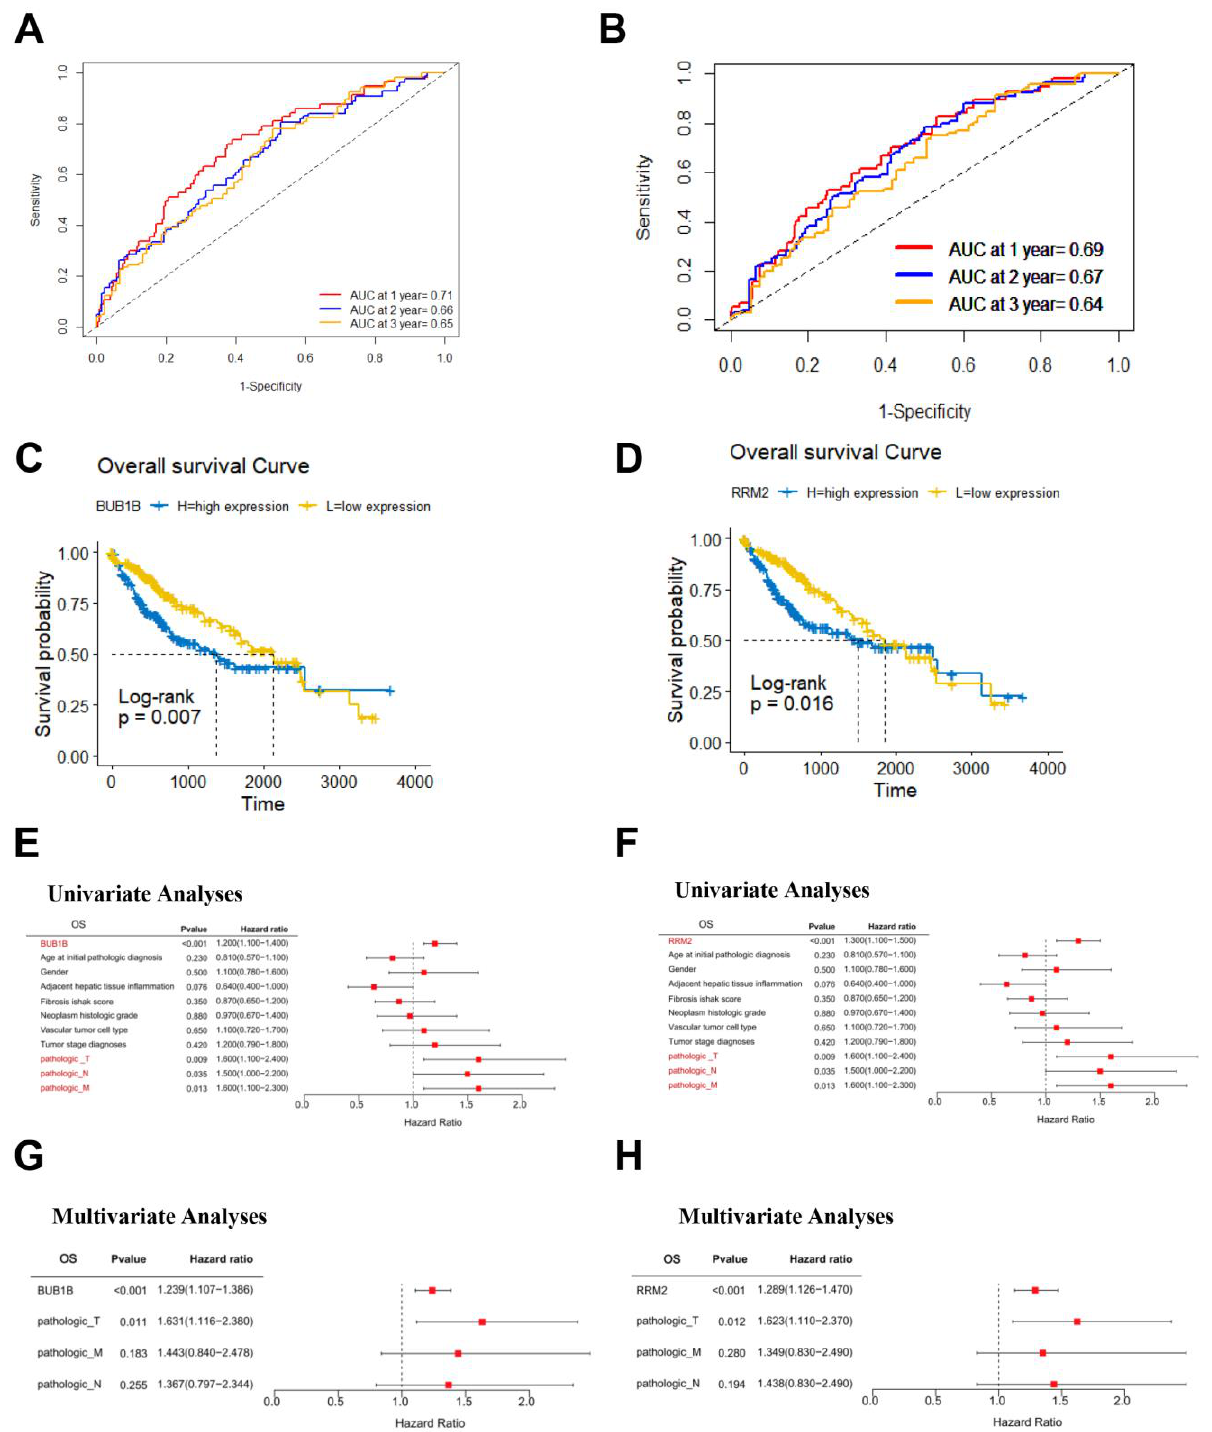
Figure 6. Survival analysis of BUB1B and RRM2 in TCGA-LIHC cohort. ( A , B ) ROC curves of TCGA- LIHC cohort. The AUC values shown the predictive efficiency of BUB1B and RRM2 on the 1-, 2-, and 3-years survival rate. ( C , D ) The overall survival analysis of BUB1B and RRM2 in TCGA-LIHC cohort. ( E – H ) Univariate and multivariate Cox analyses evaluated the independent prognostic value of BUB1B and RRM2 in terms of OS in TCGA-LIH .